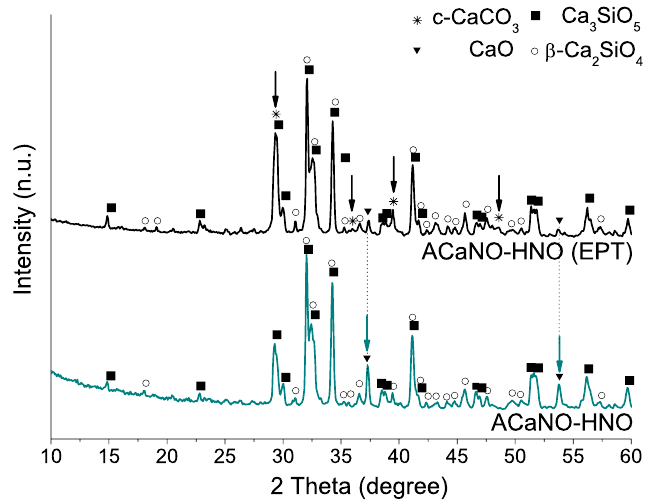
Figure 5. XRD patterns of unhydrated sol – gel BECs heat-treated at 1400 °C: without post-synthesis treatment (ACaNO-HNO), and after EPT (ACaNO-HNO (EPT)).